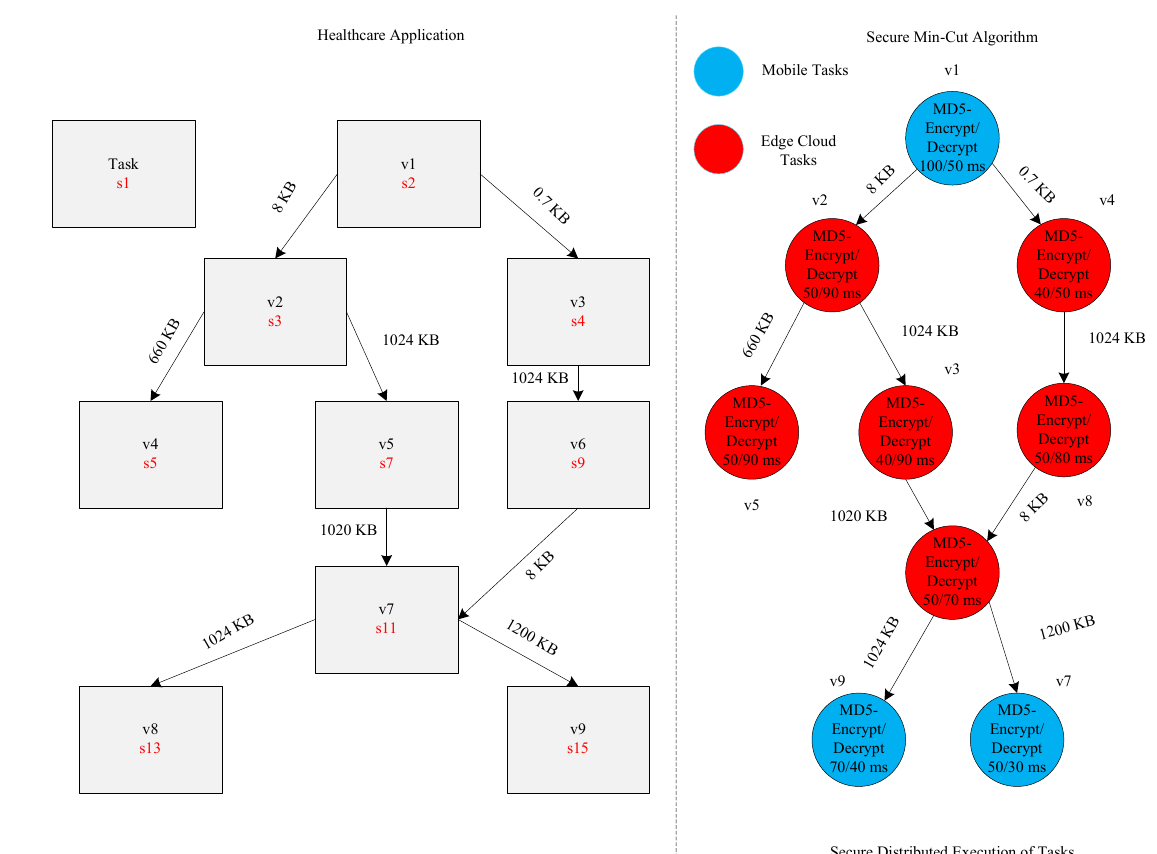
Figure 2. Secure min-cut